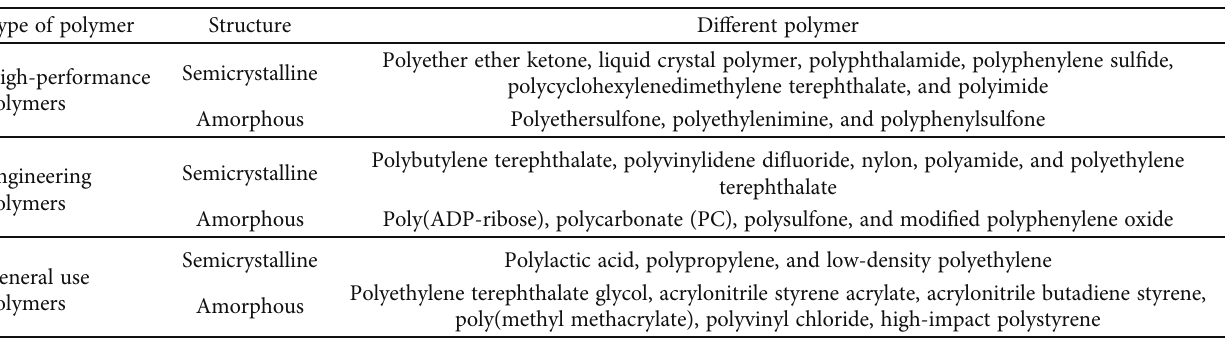
Figure 10: General optimization problems and methodology in the material extrusion process. Table 1: Di ff erent types of polymers [84 –